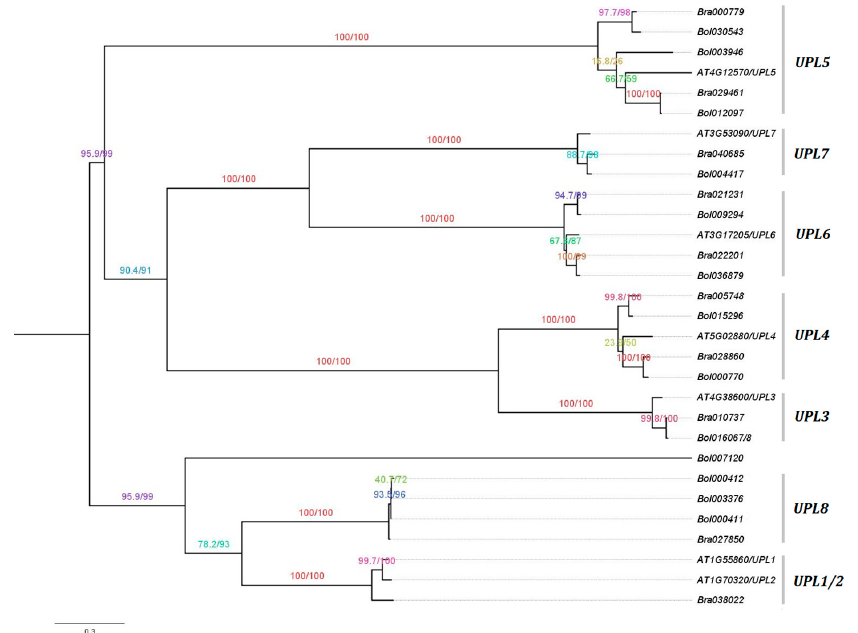
Figure 1. Phylogenetic tree of Brassica rapa , Brassica oleracea and Arabidopsis thaliana HECT genes. The tree was generated by maximum likelihood using the IQ-TREE software [36] with a perturbation strength of 0.8, and visualized in FigTree v1.4.3 (http://tree.bio.ed.ac.uk/software/figtree/) using the midpoint rooting option. The branches that correspond to the seven phylogenetic groups (i.e., UPL1 / 2 , UPL3 , UPL4 , UPL5 , UPL6 , UPL7 and UPL8 ) defined in a previous study by Mar í n [18] are labelled. Numbers indicate the SH-aLRT support (%) / ultrafast bootstrap support (%) assessed with 1000 replicates each. The scale bar is indicated at the bottom of the figure. UPL: ubiquitin-protein